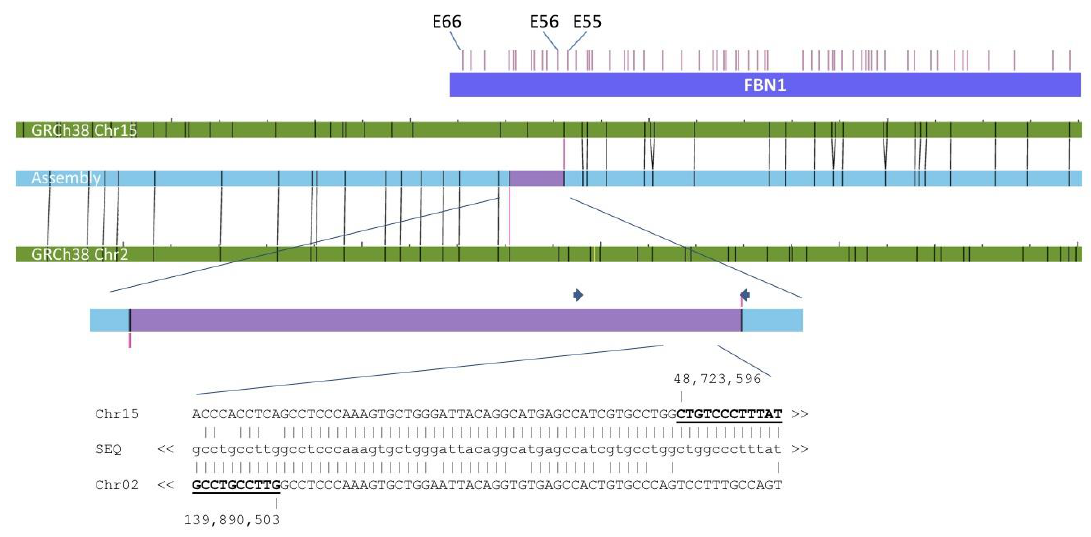
Figure 2. Optical map depicting the breakpoint within the FBN1 gene, leading to its disruption. The region was amplified by PCR (primer depicted as grey arrows) and sequenced, further specifying the breakpoint being located within intron 55 of the FBN1 gene. The alignment of the sequenced amplicon (SEQ) to the corresponding regions of chromosomes 2 and 15 revealed a 45 base pair region difficult to map to either of the chromosomes due to high sequence homology.